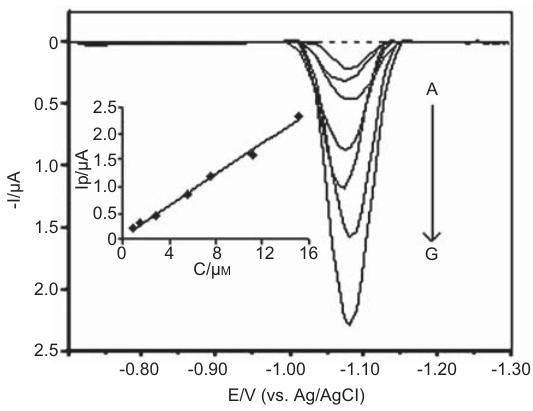
Figure 4 The stripping voltammograms for increasing levels of ABA concentrations 0.756 – 15.08 µ m (A – G) in phosphate buffer, pH 3.0 (with 0.02 m NaCl) and dashed line represents the blank solution at pencil-lead BiFE. Inset depicts a corresponding calibration plot for the quantitation of ABA. SWV parameters: frequency, 100 Hz; scan increment, 8 mV; pulse amplitude, 30 mV.